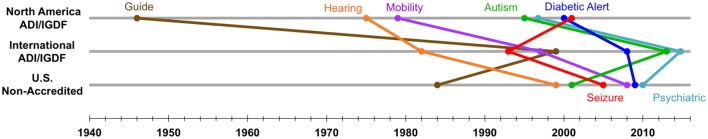
Weighted median years of facility establishments (weighted by the median numbers of dogs placed in the seven roles during 2013), shown for accredited North American and other international facilities, as well as non-accredited U.S. facilities.